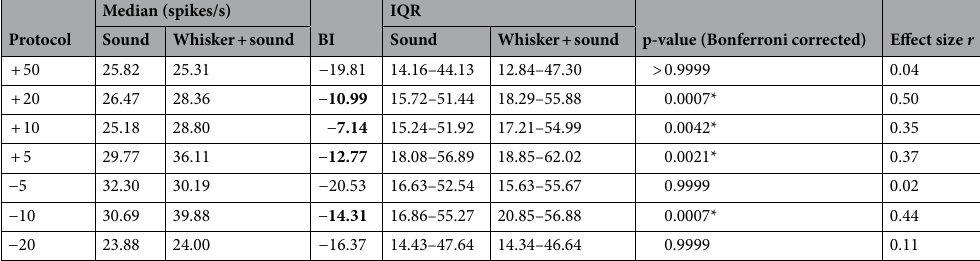
Table 1. Fusiform cells in DCN. * Statistically significant changes (p < 0.01; Wilcoxon matched-pairs signed rank test, with Bonferroni correction). IQR = interquartile range. BI = bimodal integration index (mean). BI values are in bold when there was a significant change in median spiking between “sound” and “whisker + sound” stimulation. Positive BI values would show a bimodal enhancement. Bold values close to zero would show that there is no bimodal integration (just an additive effect of the whisker response). Bold negative BI values mean, that the bimodal response was larger than only sound, but not larger than the sum of sound and whisker stimulation alone. Negative BI values, without a significant difference between sound and whisker + sound, indicates that whisker stimulation alone evoked a